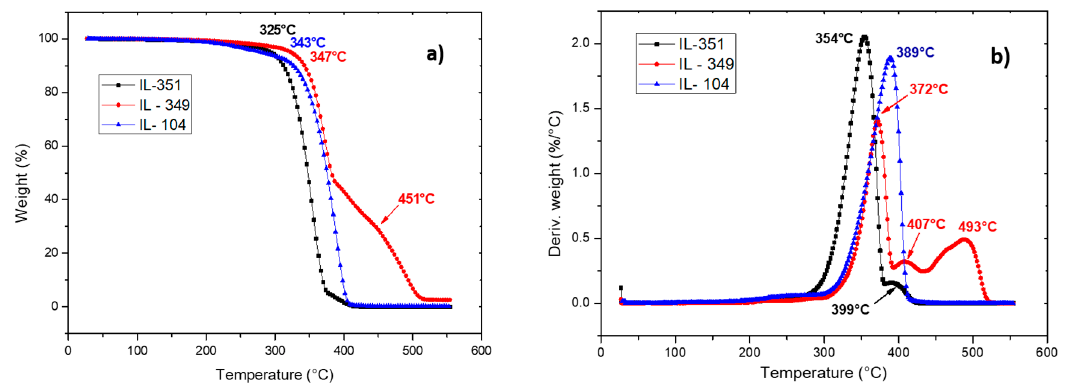
Figure 1. Evolution of weight loss as a function of temperature (thermogravimetric analysis (TGA) ( a ); ( b ) derivative thermo-gravimetric (DTG)) of pure ionic liquids (ILs). (heating rate 20 K·min − 1 , under nitrogen flow).